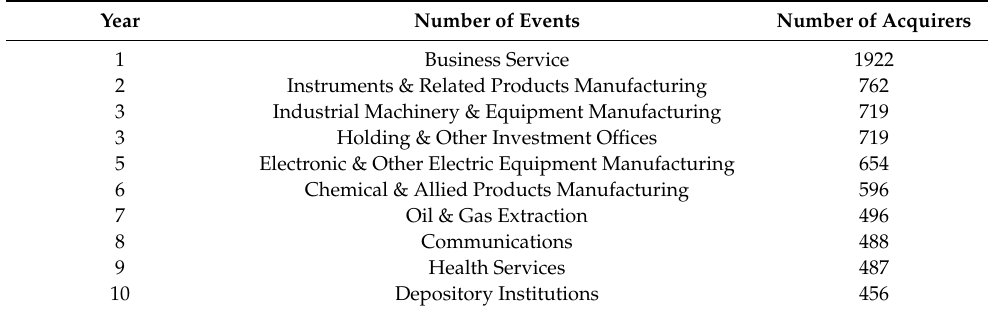
Table A1. Top 10 Acquirer Industries.